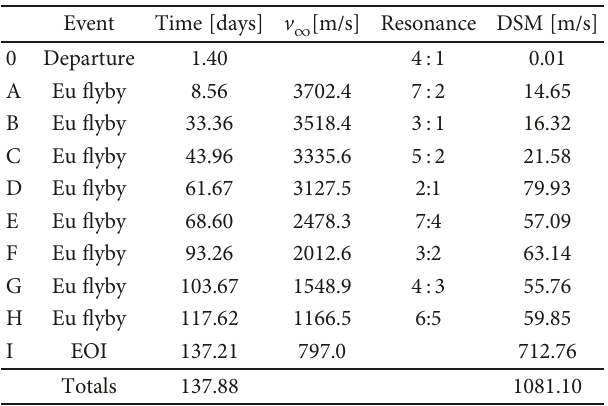
Figure 7: Tisserand graph of solution A. Axes are normalized with respect to Europa semi-major axis. Table 2: Solution “ B ”— mission features.